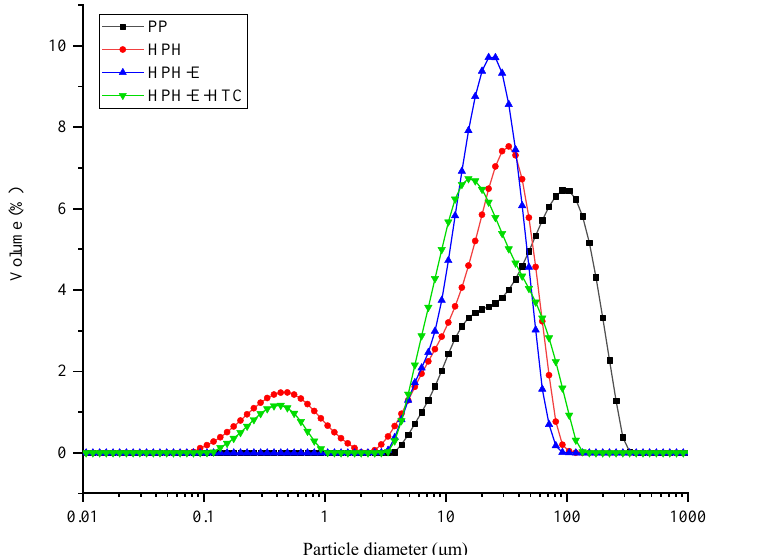
Figure 7. Particle size (D (4,3)) distributions of peanut protein (PP), high pressure homogenized protein (HPH), high pressure homogenized and enzyme treated protein (HPH-E), and HPH-E- hydrothermally cooked (HPH-E-HTC) protein. Table 1. Particle-size distributions of peanut protein (PP), high pressure homogenized protein (HPH), high pressure homogenized and enzyme (E) treated protein (HPH-E), and HPH-E-hydrothermally cooked (HPH-E-HTC) protein.